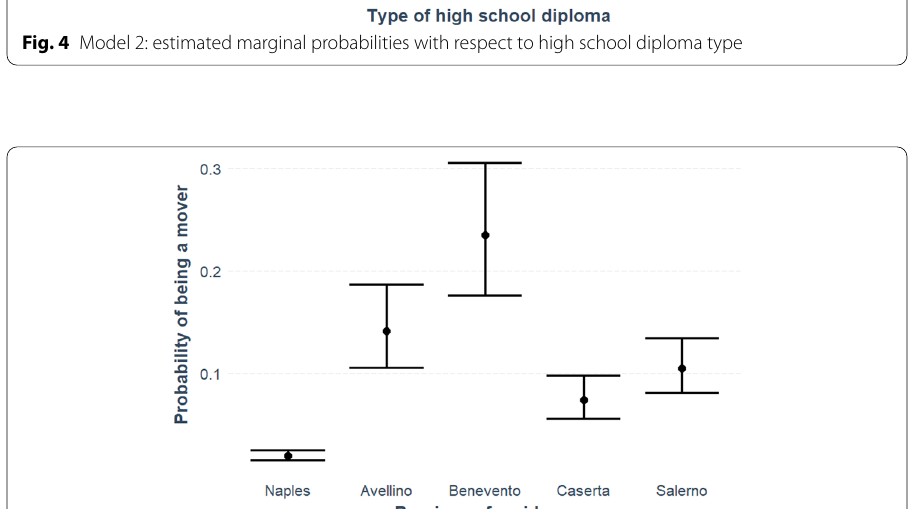
Fig. 5 Model 2: Estimated marginal probabilities with respect to provinces of residence